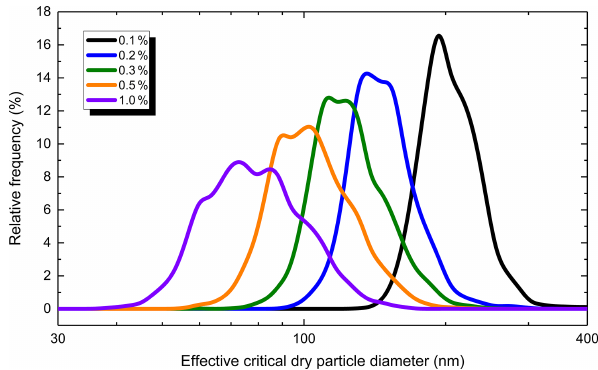
Figure 4. Differential frequency distributions of the effective criti- cal dry particle diameter at supersaturations of 0.1%, 0.2%, 0.3%, 0.5% and 1.0%; the frequencies are normalised to the total counts of diameter